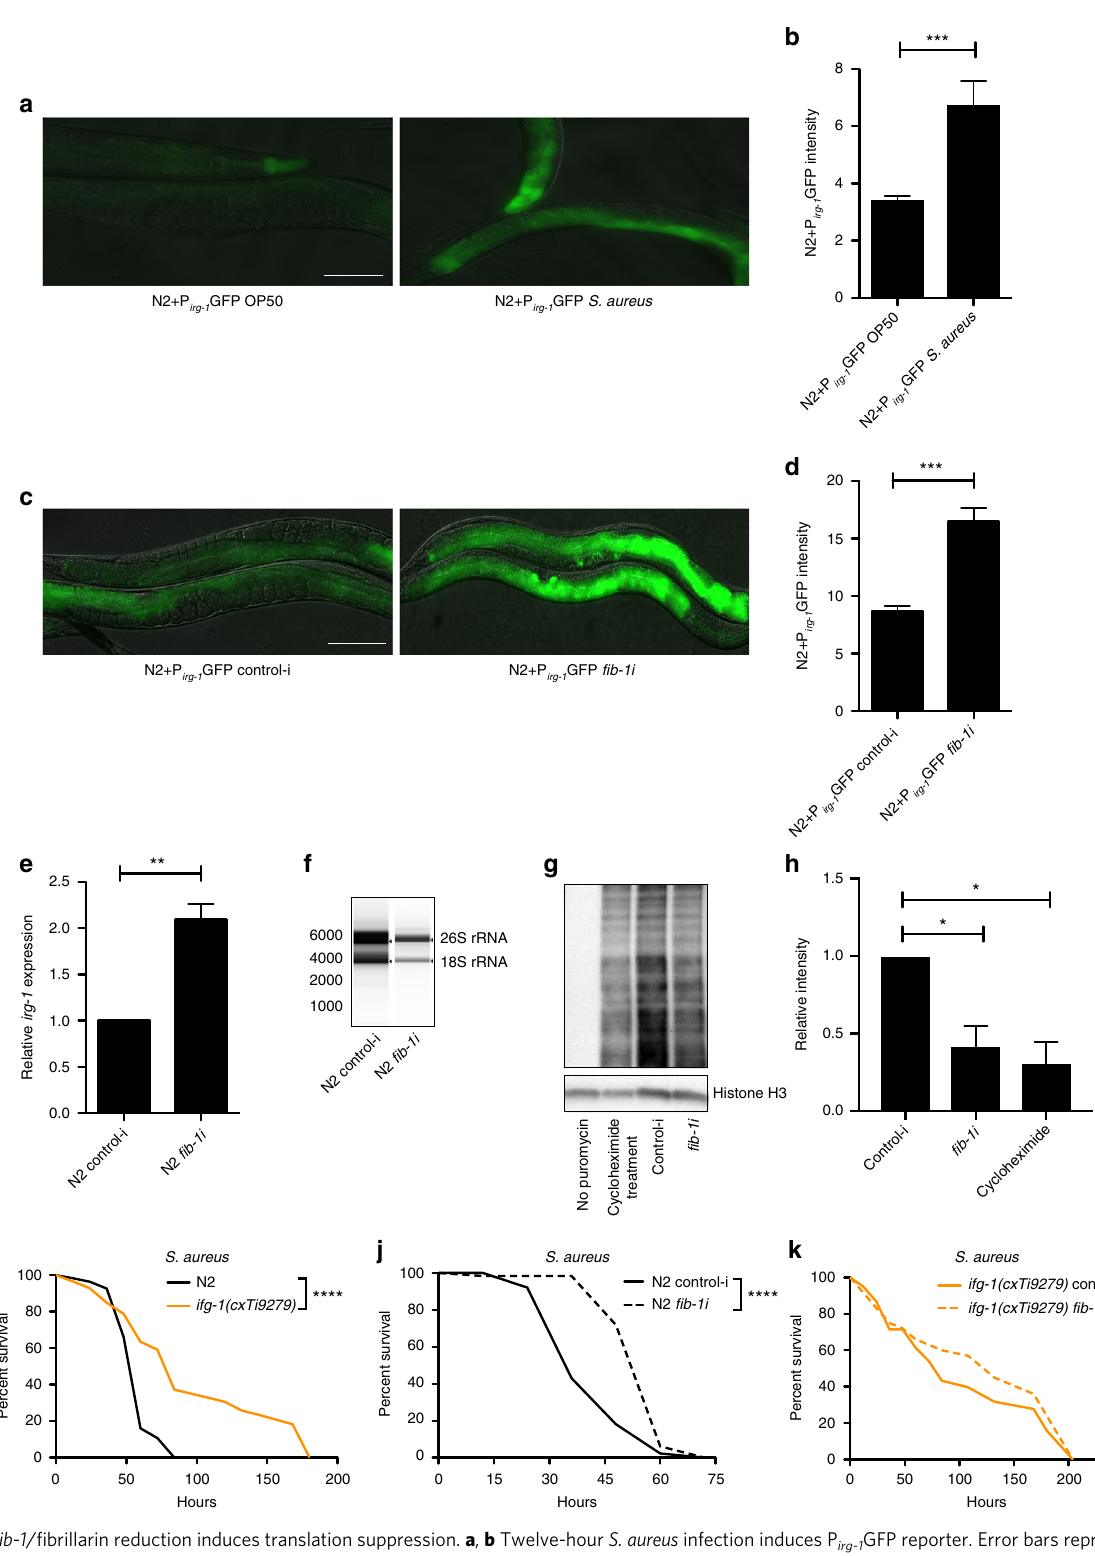
Fig. 4 fi b-1 / fi brillarin reduction induces translation suppression. a , b Twelve-hour S. aureus infection induces P irg-1 GFP reporter. Error bars represent mean